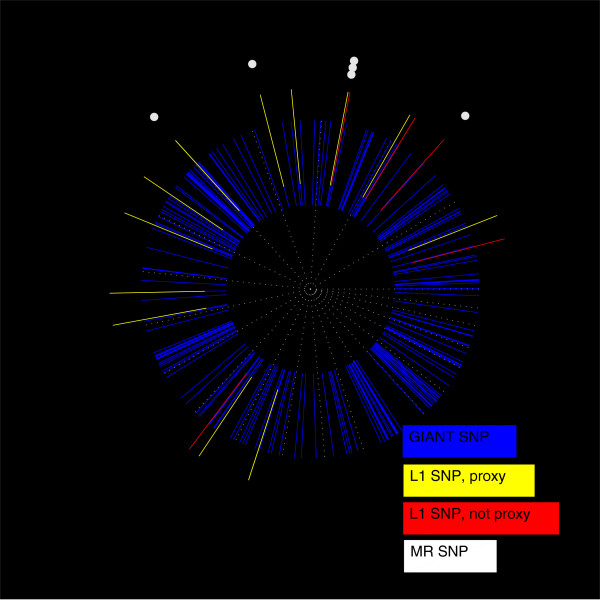
Map of SNPs associated with height, as identified by the GIANT Consortium meta-analysis, L1 -penalized regression, and standard GWAS. Base-pair distance is given by angle, and chromosome endpoints are demarcated by dotted lines. Starting from 3 o’clock and going counterclockwise, the map sweeps through the chromosomes in numerical order. As a scale reference, the first sector represents chromosome 1 and is ∼ 250 million base-pairs. The blue segments correspond to a 1 Mb window surrounding the height-associated SNPs discovered by GIANT. Note that some of these may overlap. The yellow segments represent L1 -selected SNPs that fell within 500 kb of a (blue) GIANT-identified nonzero; these met our criterion for being declared true positives. The red segments represent L1 -selected SNPs that did not fall within 500 kb of a GIANT-identified nonzero. Note that some yellow and red segments overlap given this figure’s resolution. There are in total 20 yellow/red segments, representing L1 -selected SNPs found using all 12,454 subjects. The white dots represent the locations of SNPs selected by MR at a P -value threshold of 10− 8.